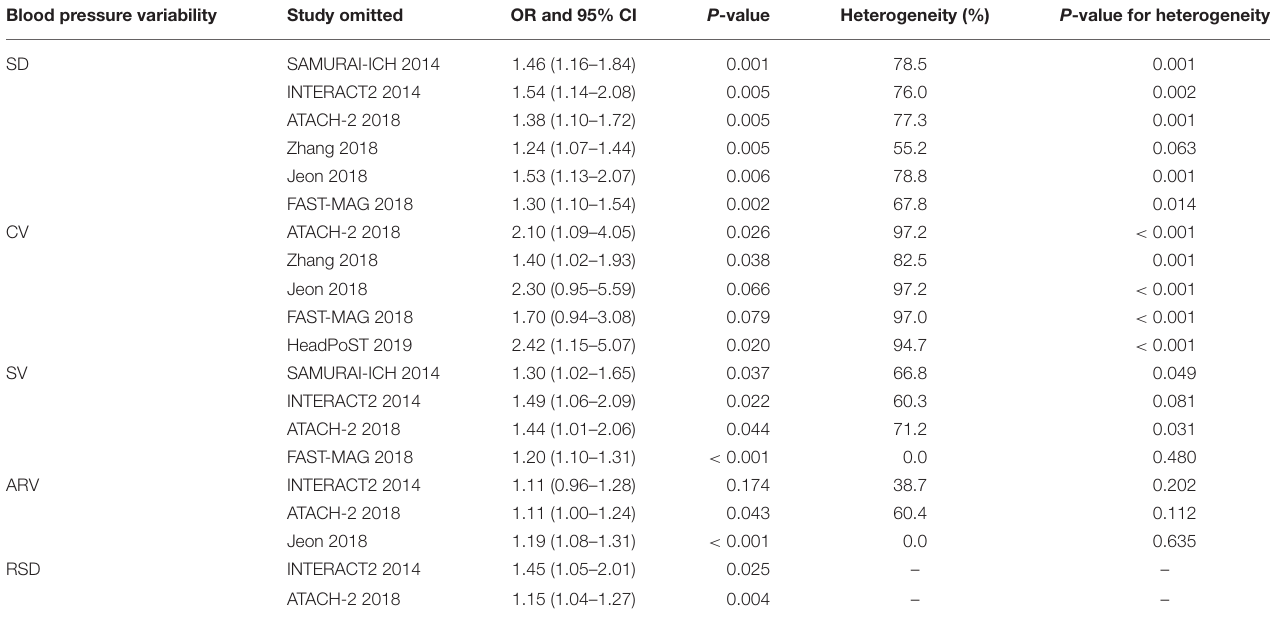
TABLE 2 | Sensitivity analysis for the risk of poor outcomes.